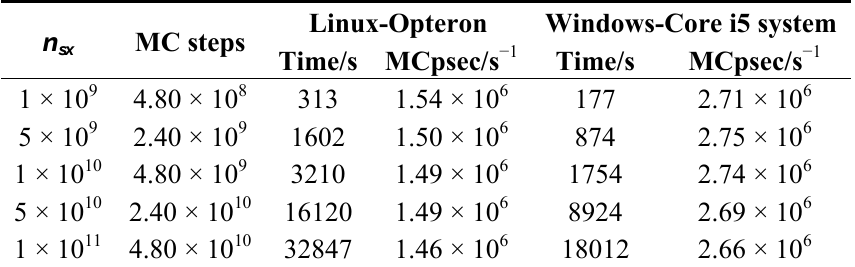
Table 13. Performance analysis; Reaction time = 1